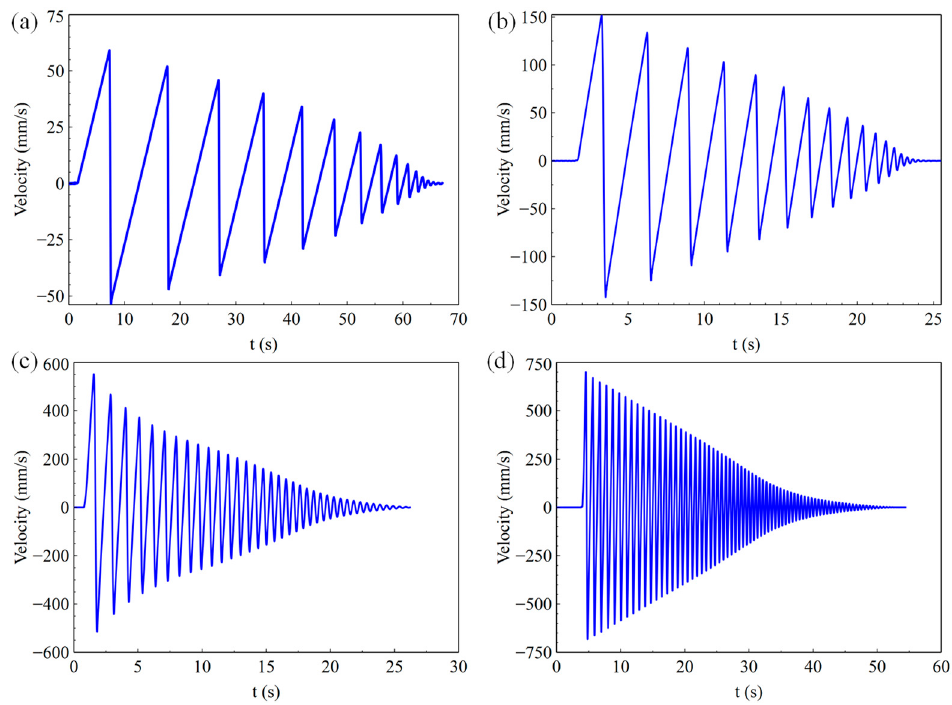
Figure 12. Velocity of the landing buffer tests with external force of ( a ) 0.98 N, ( b ) 9.8 N, ( c ) 96 N, ( d ) 196 N.